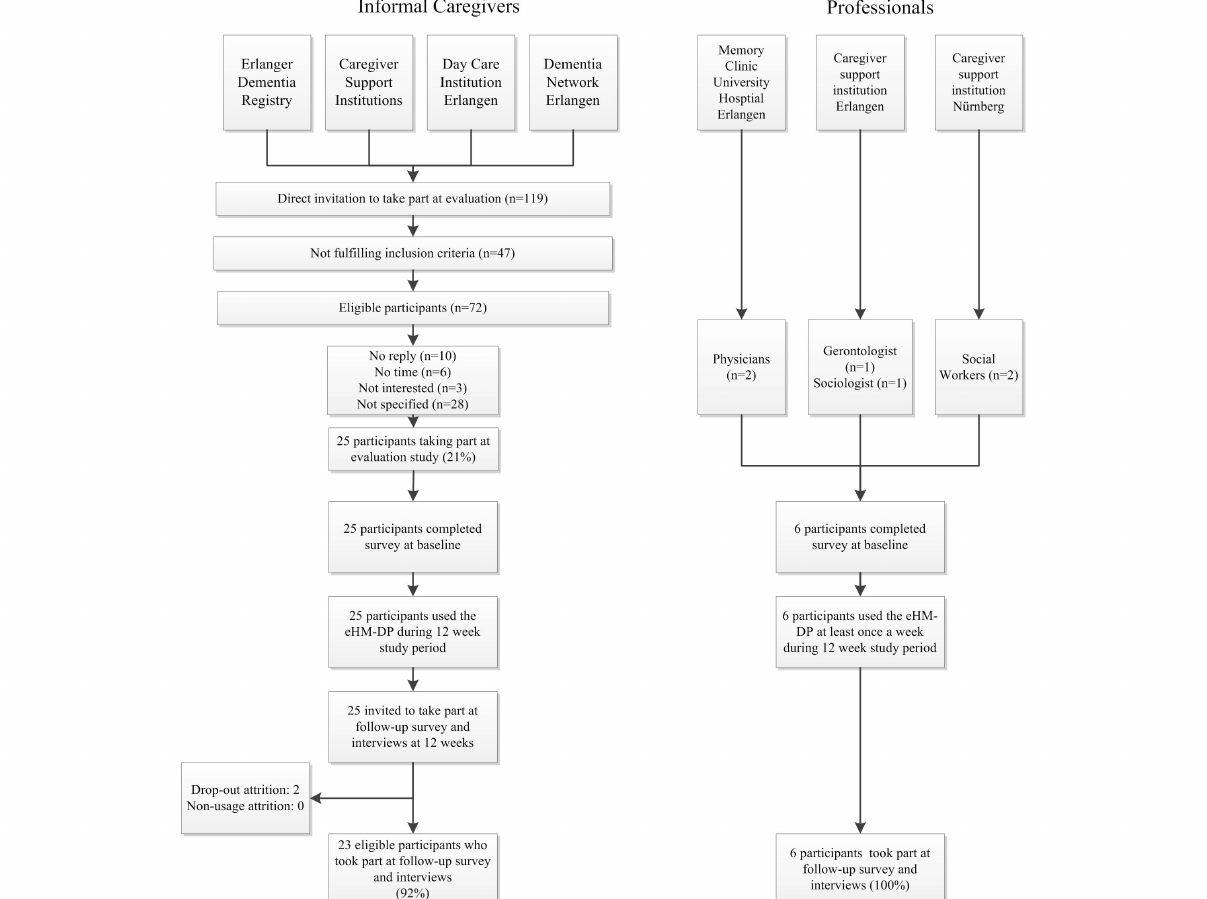
Figure 2. Schematic representation of the eHM-DP evaluation participant